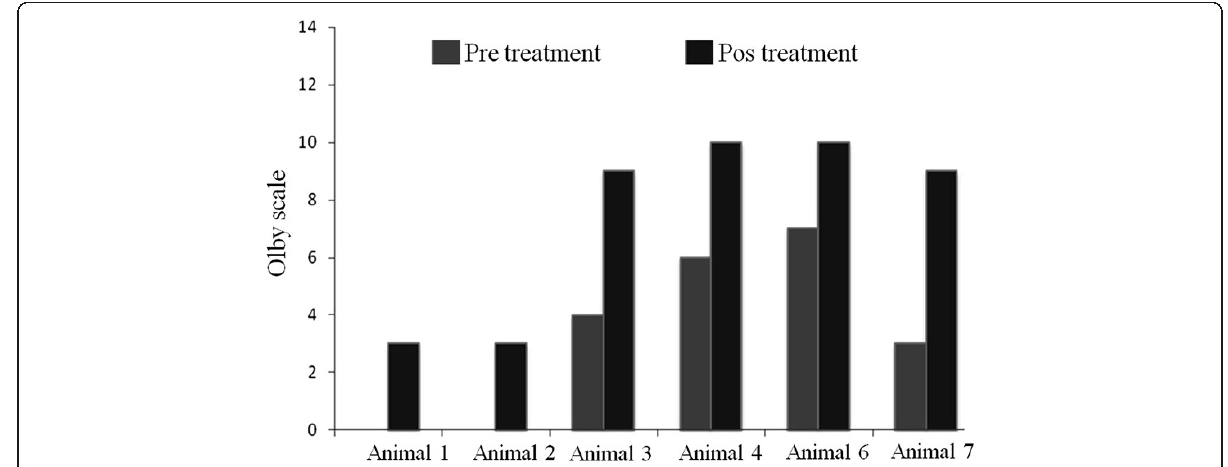
Figure 2 Evolution of the animals according to the scale of Olby